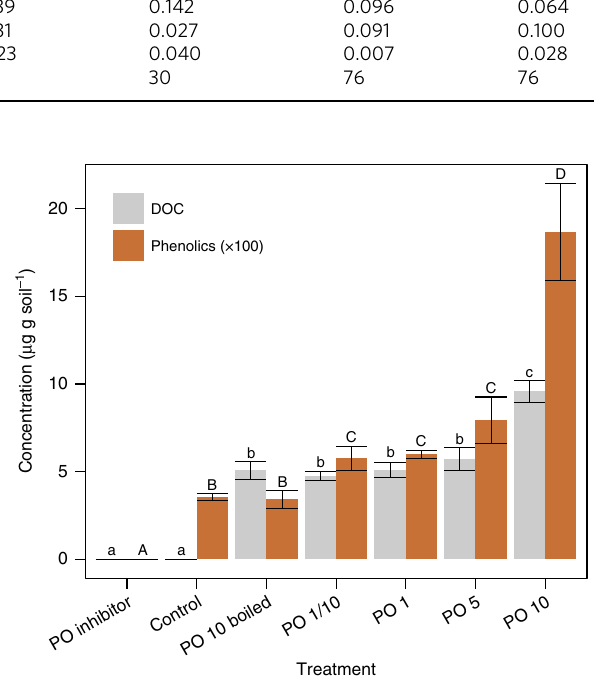
Fig. 5 Effects of phenol oxidase additions or inhibition on DOC and phenolic concentrations in peat slurry. Different letters represent signi fi cant differences in DOC (lower case) or phenolics (upper case) among different